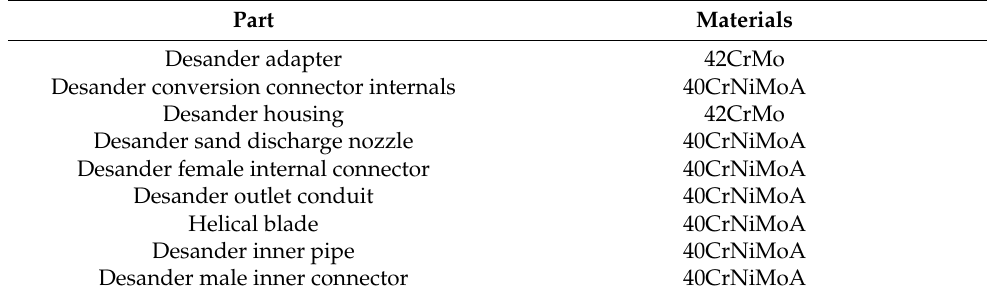
Table 1. Material list of parts of the downhole solid–liquid